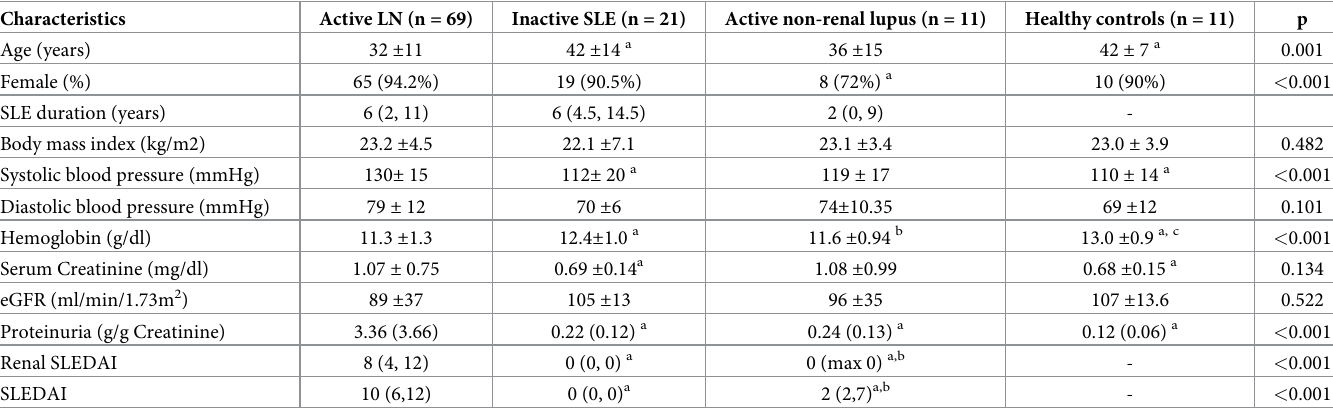
Table 1. Baseline characteristics of SLE patients and healthy